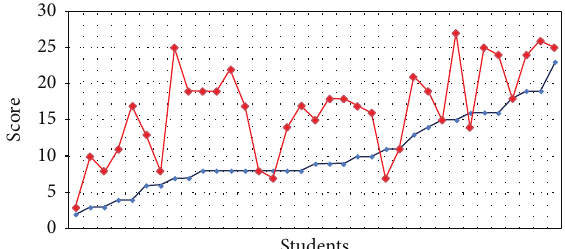
Figure 6: Line graph of the scores in the pretest and posttest.